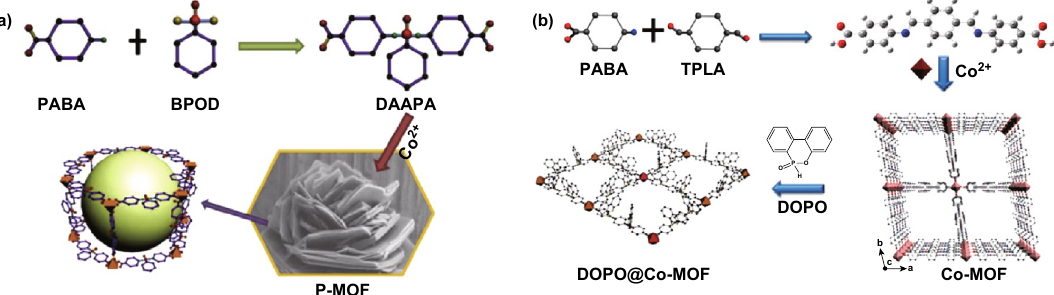
Fig. 10 Two methods for preparing the phosphorus modified MOF as FRs. Reproduced from Ref. [25] with permission from Elsevier and Ref. [68] with permission from American Chemical